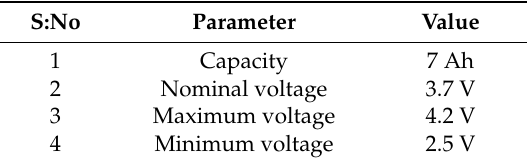
Table A1. The specifications of a single cell of a Li-ion battery .